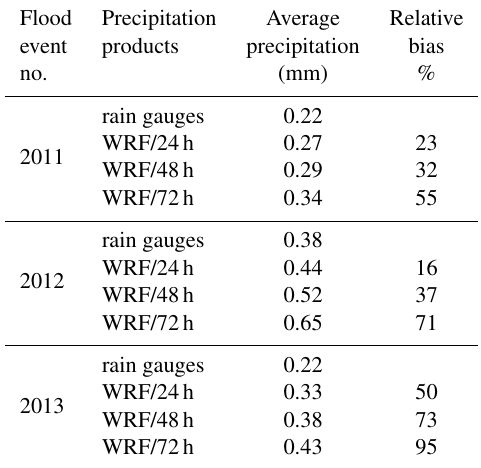
Table 1. Precipitation comparison of two